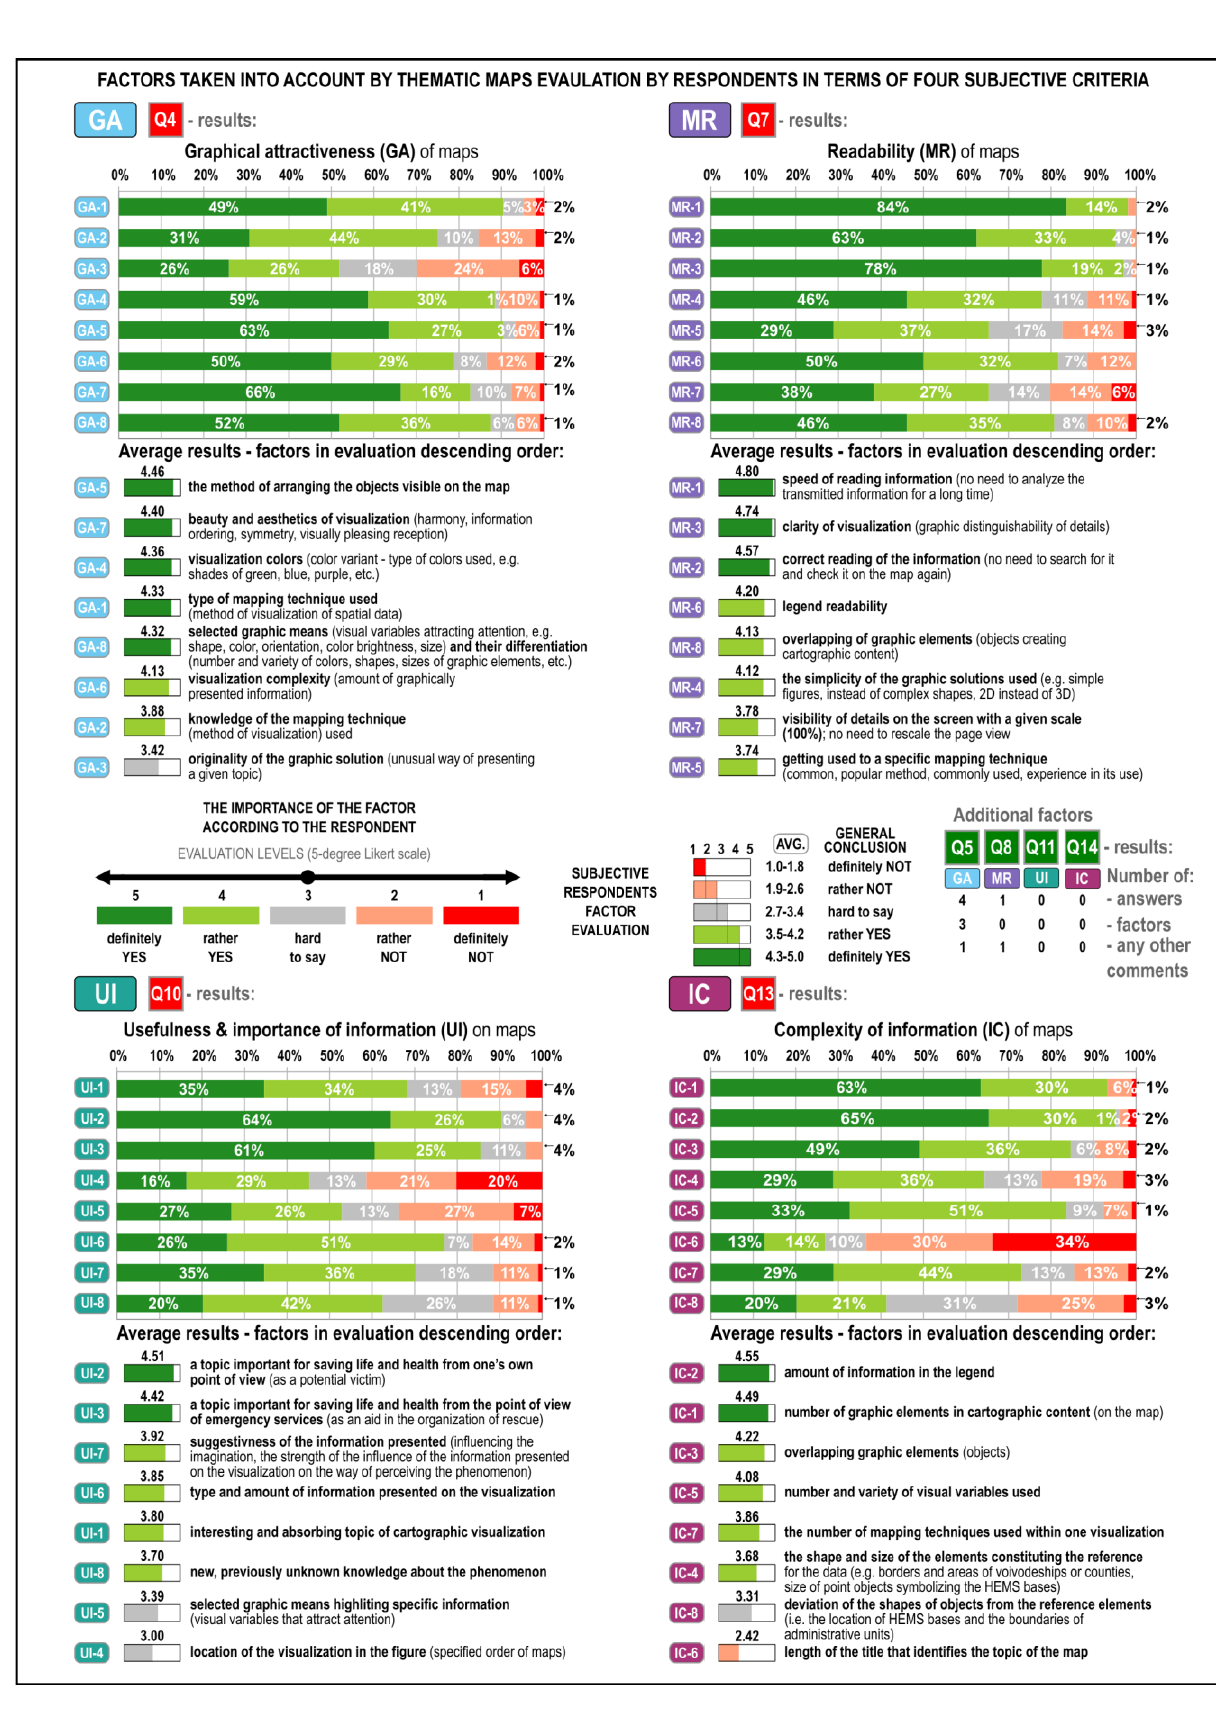
Figure 6. Detailed and generalized (averaged) results of users’ evaluation of factors that may affect the way of assessing thematic maps in terms of graphical attractiveness (GA), map readability (MR), information usefulness and importance (UI), and information complexity (IC).